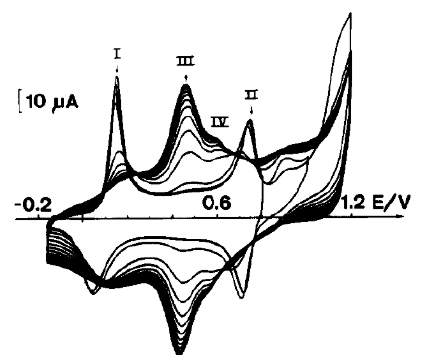
Figure 5. Modifications in the cyclic voltammetric curves at 100 mV/s on a polyaniline film during cycling, from − 0.2 V to 1 and 1.2 V in NH 4 F:2.3 HF. Reference electrode: Cu/CuF. Reprinted from [36], Copyright 1988, with permission from